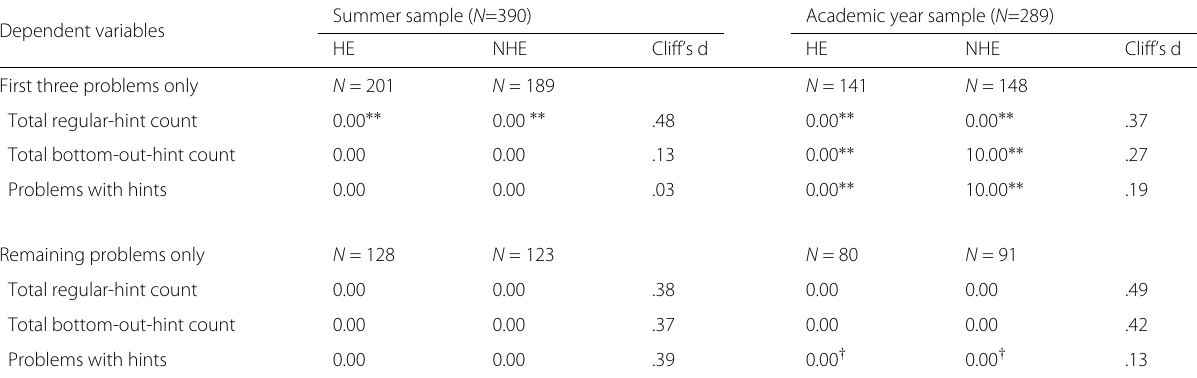
Table 6 Medians and effect sizes of help-seeking-behavior measures by condition for both samples Dependent variables